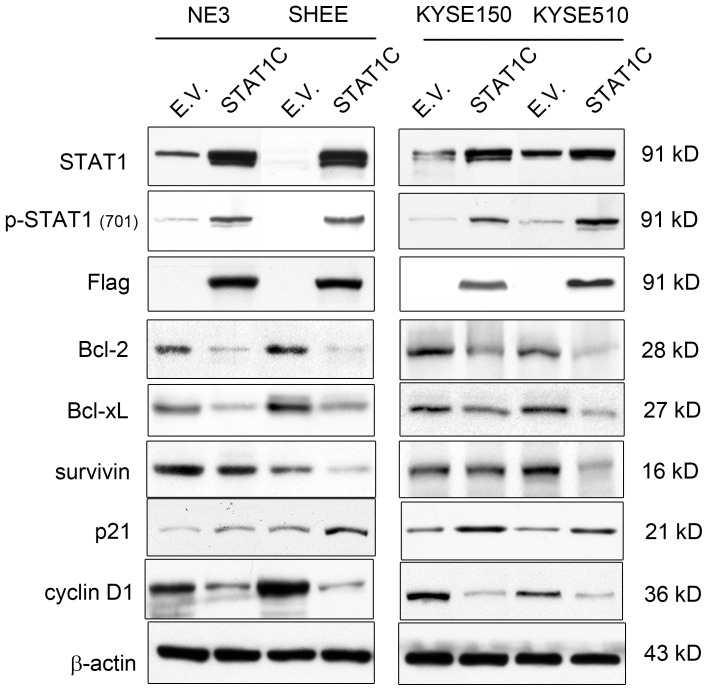
Gene transfection of STAT1C upregulated apoptosis in ESCC cell lines.Using Western blot analysis, the gene transfection of STAT1C in SHEE, NE3, KYSE150 and KYSE510 cells was shown to be effective, since the levels of STAT1, phospho-STAT1 and FLAG were dramatically increased 2 days after STAT1C transfection. By western blots, gene transfection of STAT1C into these cell lines down-regulated several pro-apoptotic proteins (including BCL-2, BCL-xL, survivin), and promoted G1 cell-cycle arrest by decreasing cyclin D1 and increasing p21waf1. Cell lysates were collected 2 days after the gene transfection of STAT1C in all the cell lines.